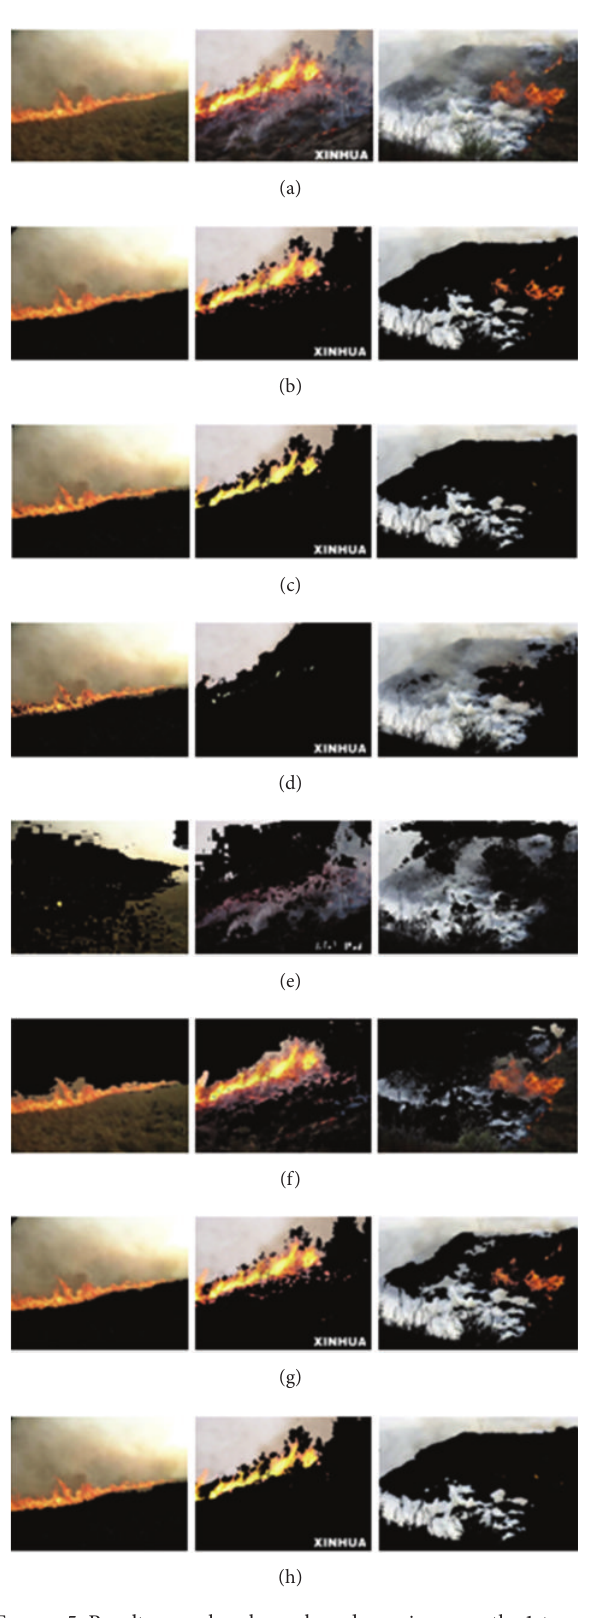
Figure 5: Results on color channels and gray images—the 1st row: input images; the 2nd row to 8th row: segmentations of R, G, B, H, S, V channels and gray images.